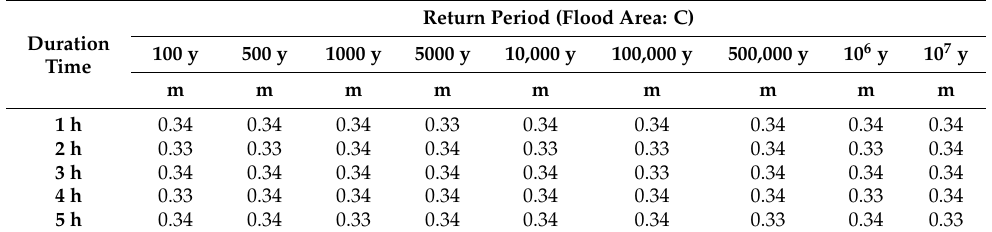
Table 8. Maximum flood depth in the control building of NPP 4 (elevation 80 ft, 2D analysis